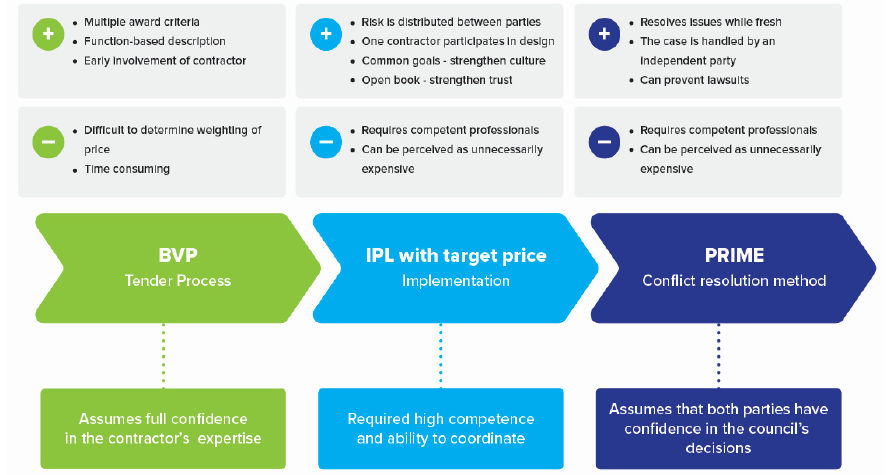
Figure 12. Suggested methods to prevent disputes in construction projects.